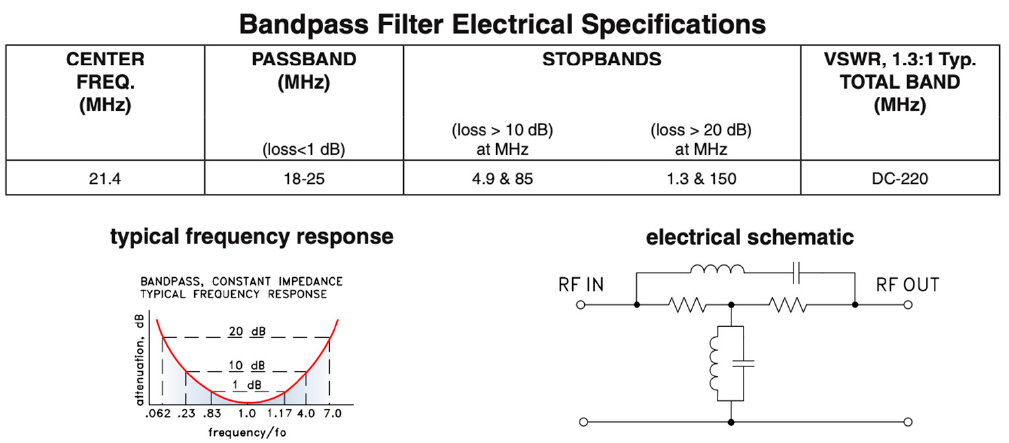
Figure 8. Filtering stage and frequency response.